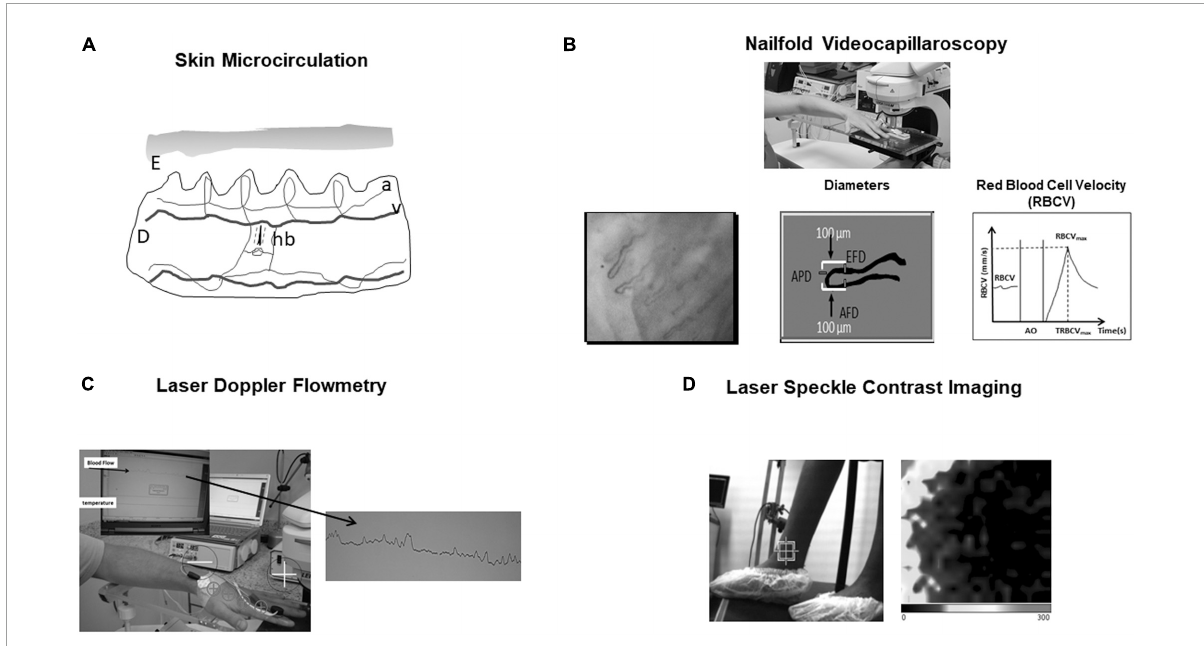
FIGURE1 (A) Skin microcirculation. E, epidermis; D, dermis; a, arteriole; v, venule; hb, hair bulb. (B) Nailfold videocapillaroscopy—One can see how afferent, apical, and efferent capillary diameters (AFD, APD, and EFD) are obtained. Also, baseline Red Blood Cell Velocity (RBCV), RBCV maximum (RBCV max ), and time to reach RBCV max after arterial occlusion (AO) release are shown. (C) Laser Doppler flowmetry. Blood flow is expressed by perfusion index in arbitrary units. Iontophoresis may be associated to evaluate microvascular function. (D) Laser speckle contrast imaging. 2-D perfusion maps of tissue surfaces and perfusion in arbitrary units are created. Darker color represents low blood flow and lighter color higher blood flow. Here it can be seen the study of perimaleolar perfusion in chronic venous disease (control